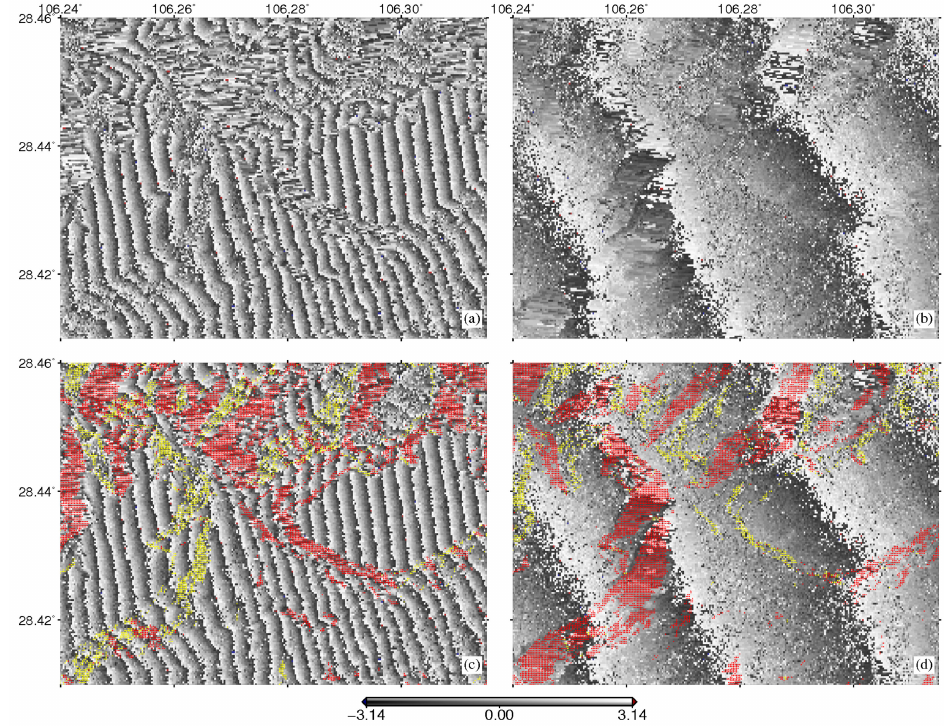
Figure 8. Interferograms derived from the ALOS ascending data ( a , c ) and the ALOS descending data ( b , d ); the red points represent the layover and the yellow points represent